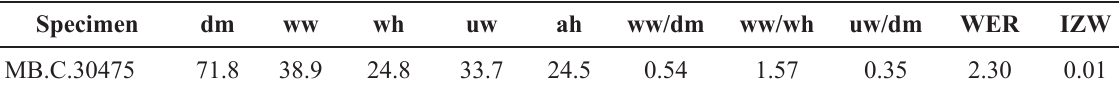
Table 12. Conch dimensions (in mm) and ratios of Vestinautilus